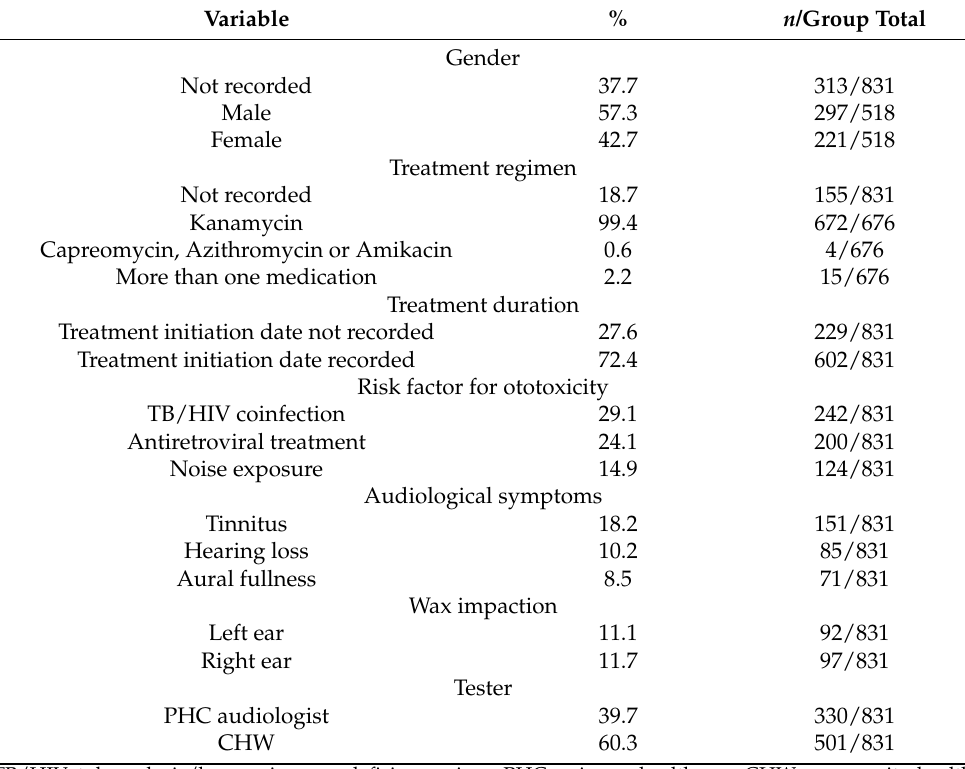
Table 1. Patient description at the time of the initial assessment ( n =